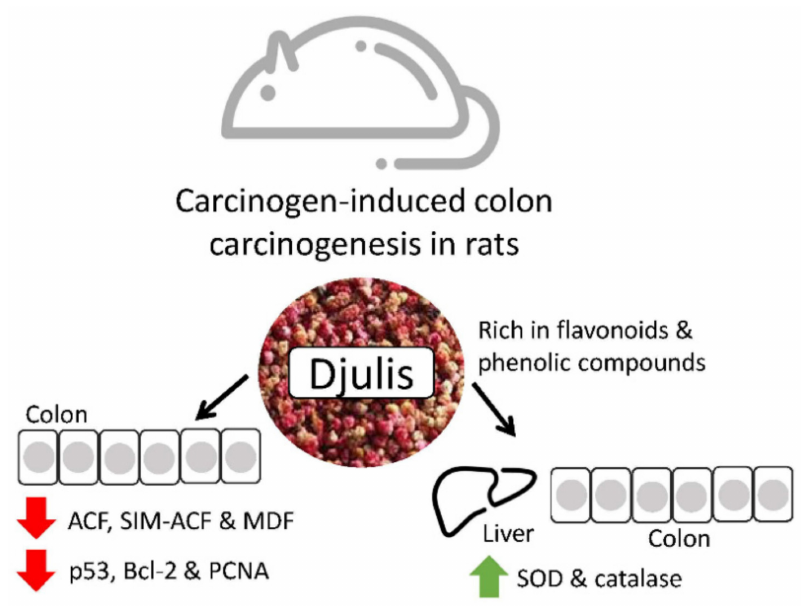
Figure 6. The effects of djulis in colon and liver cancer